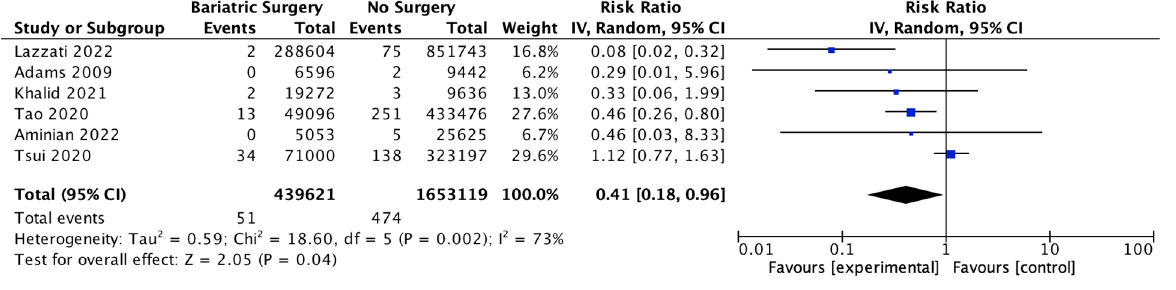
Figure 14. Gallbladder cancer incidence [38–40,42,43,49].